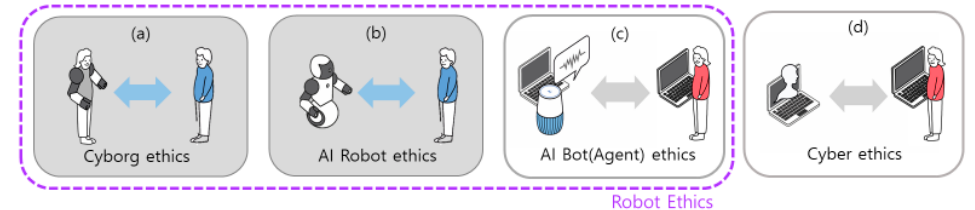
Figure 3. AI ethics among the four subcategories in information ethics by ICT